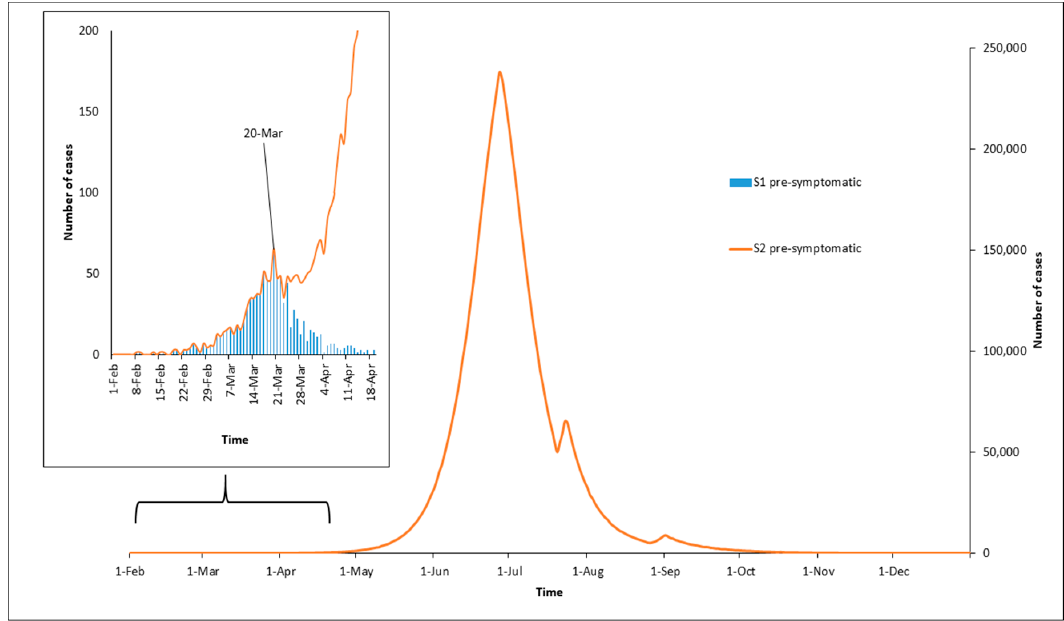
Figure 1. Simulated COVID-19 epidemic curves in Jordan under scenarios 1 and 2 (S1 and S2), utilizing the pre-symptomatic compartmental state.